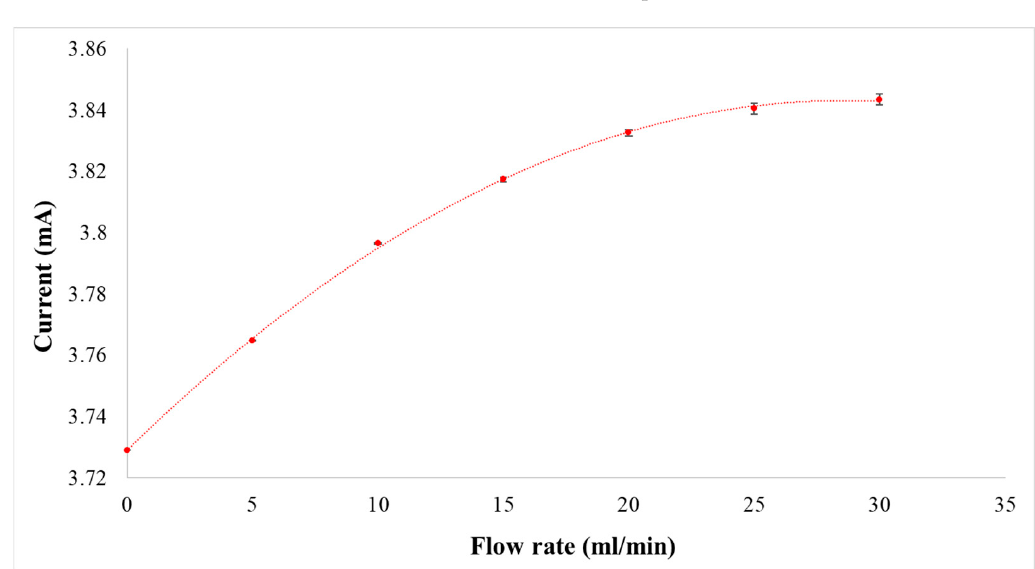
Figure 8. Correction curve of micro temperature sensor.